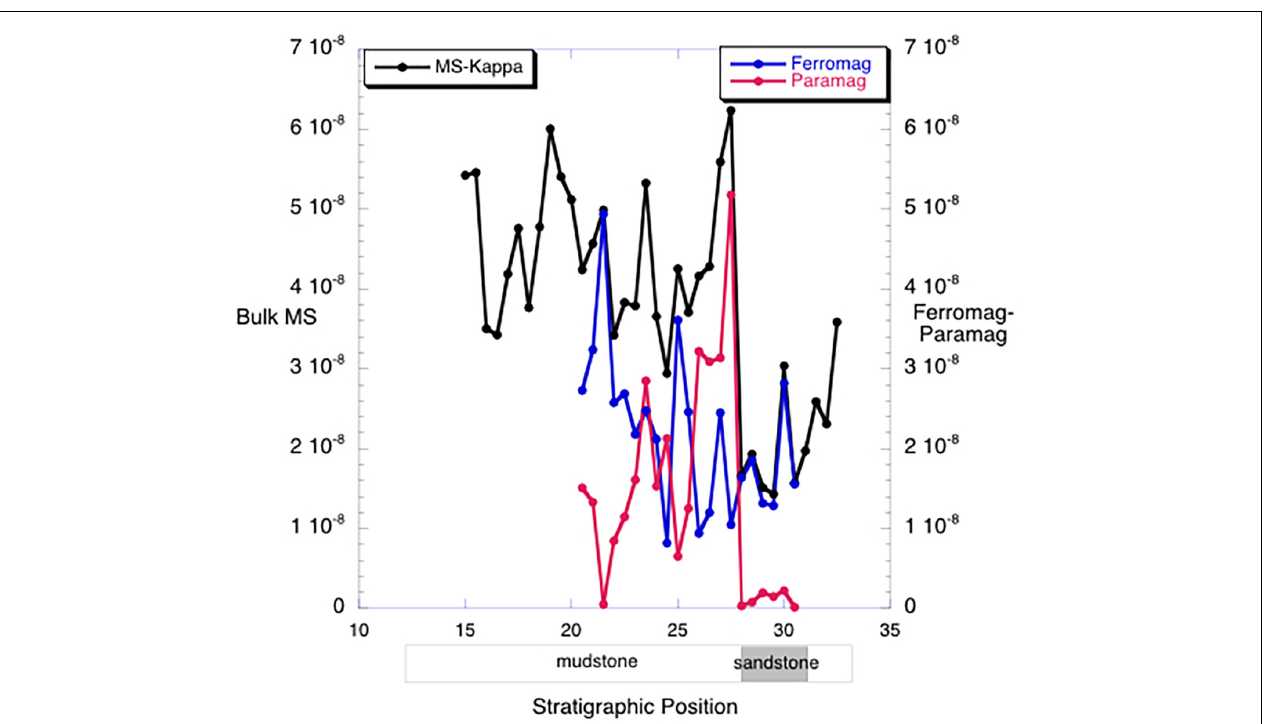
FIGURE 11 | The relative proportion of ferromagnetic minerals (blue curve) and paramagnetic minerals (red curve) contributing to the bulk susceptibility (black curve) for 10 m between 20.5 and 30.5 m in the section. The percentages determined from the low temperature MS vs. T measurements have been multiplied by the bulk susceptibility for a sample to determine the susceptibility for each magnetic mineral type. Note that the blue (ferromagnetic) curve follows all the short period peaks in the bulk susceptibility curve (black curve) indicating that the ferromagnetic mineral variations are the source of the bulk susceptibility variations. The paramagnetic mineral contribution is sometimes in phase with the ferromagnetic variations, sometimes out of phase. The magnetic susceptibility of the sandstone bed is almost all due to ferromagnetic